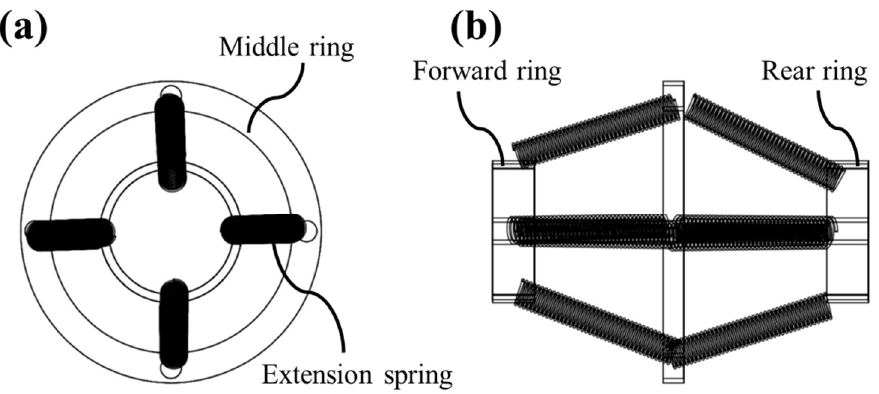
Figure 2. Structure of flexible connection vibration-damping device. ( a ) Front view. ( b ) Side